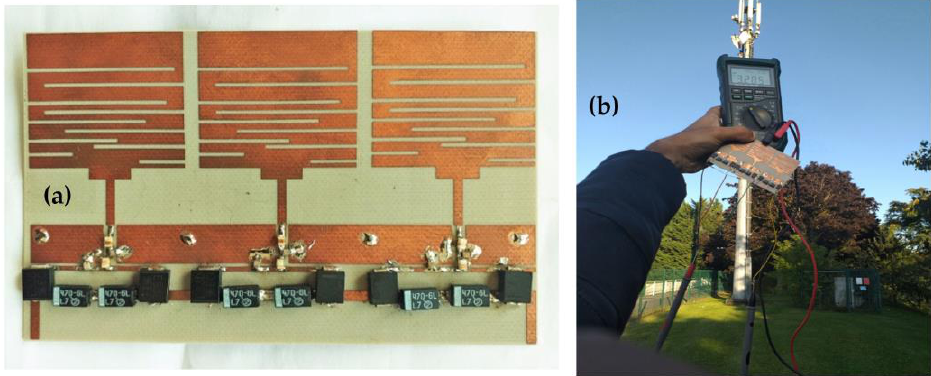
Figure 20. Measured and simulated efficiencies provided by the second architecture for 2 kΩ re- sistance load .